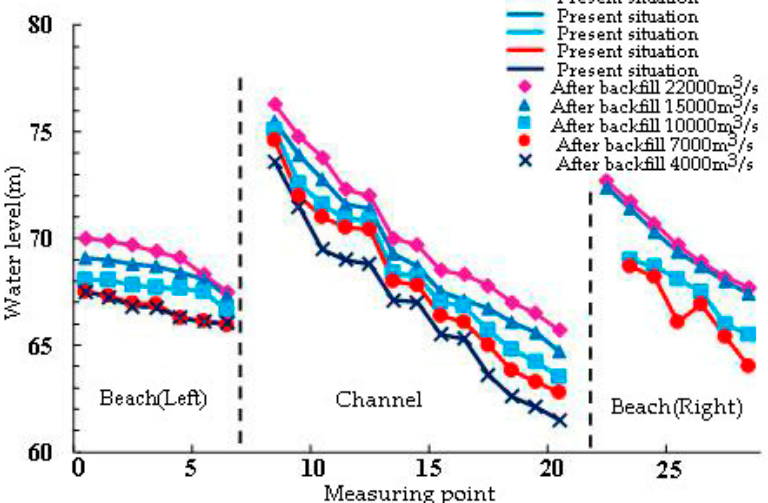
Figure 4. Comparison of flood water level in the present condition and the backfilling condition.